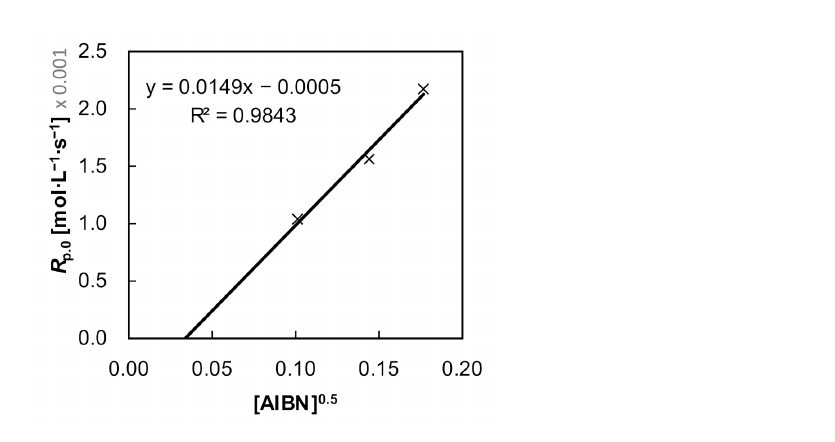
Figure 7. Linear dependence of the square root of the initiator concentration on the initial polymeri- sation